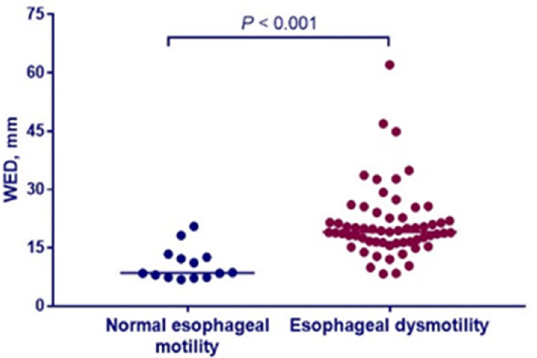
Figure 2. Widest esophageal diameter (WED) was elevated in SSc patients with esophageal dysmotil- ity (n = 61) compared to those with normal esophageal motility (n =